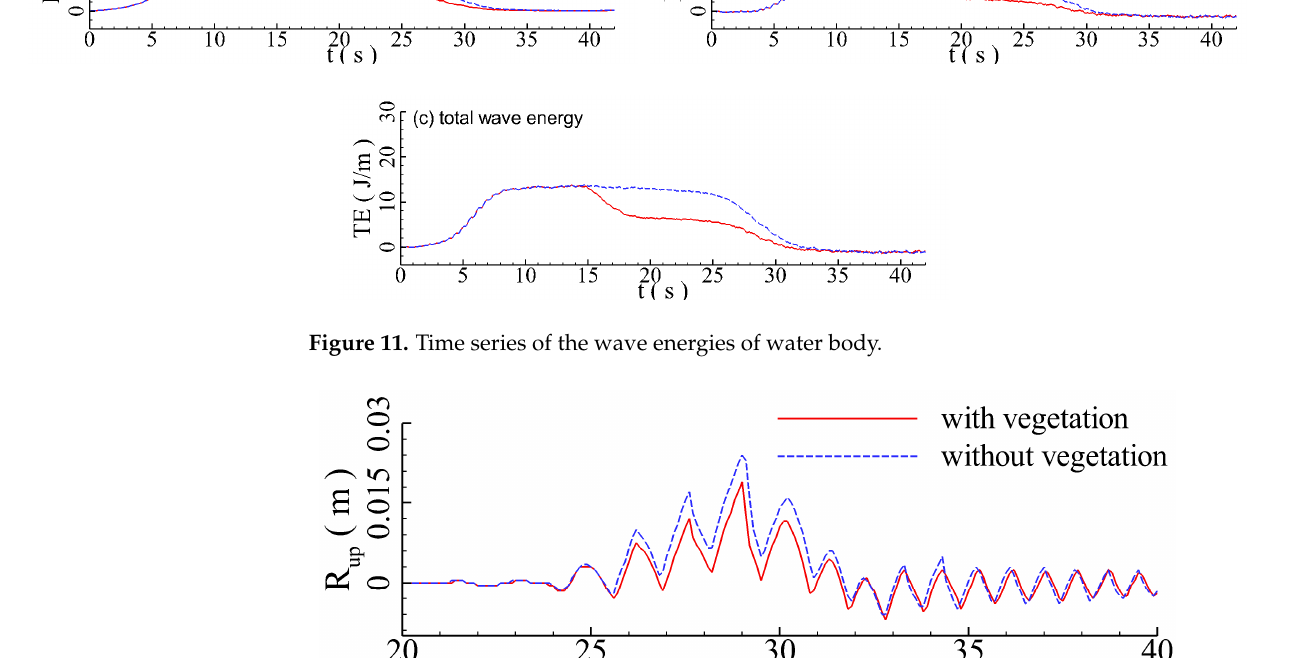
Figure 11. Time series of the wave energies of water body.